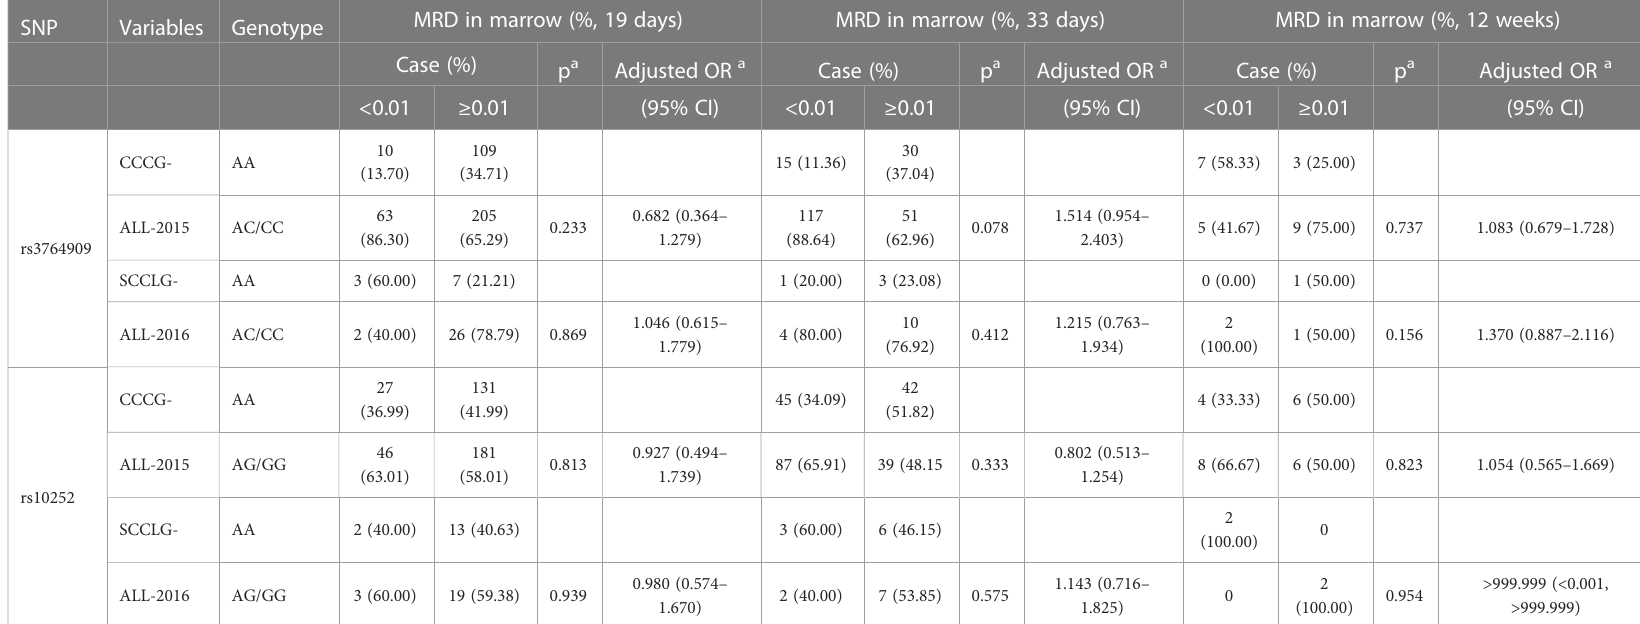
TABLE 4 The in fl uence of m5C-related gene polymorphisms on sensitivity to different treatment strategies based on MRD